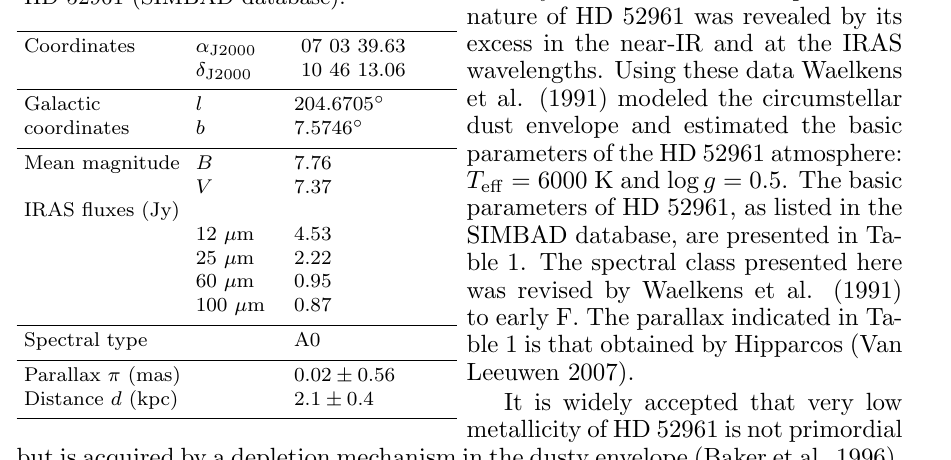
Table 1. Basic parameters of PS Gem = HD 52961 (SIMBAD